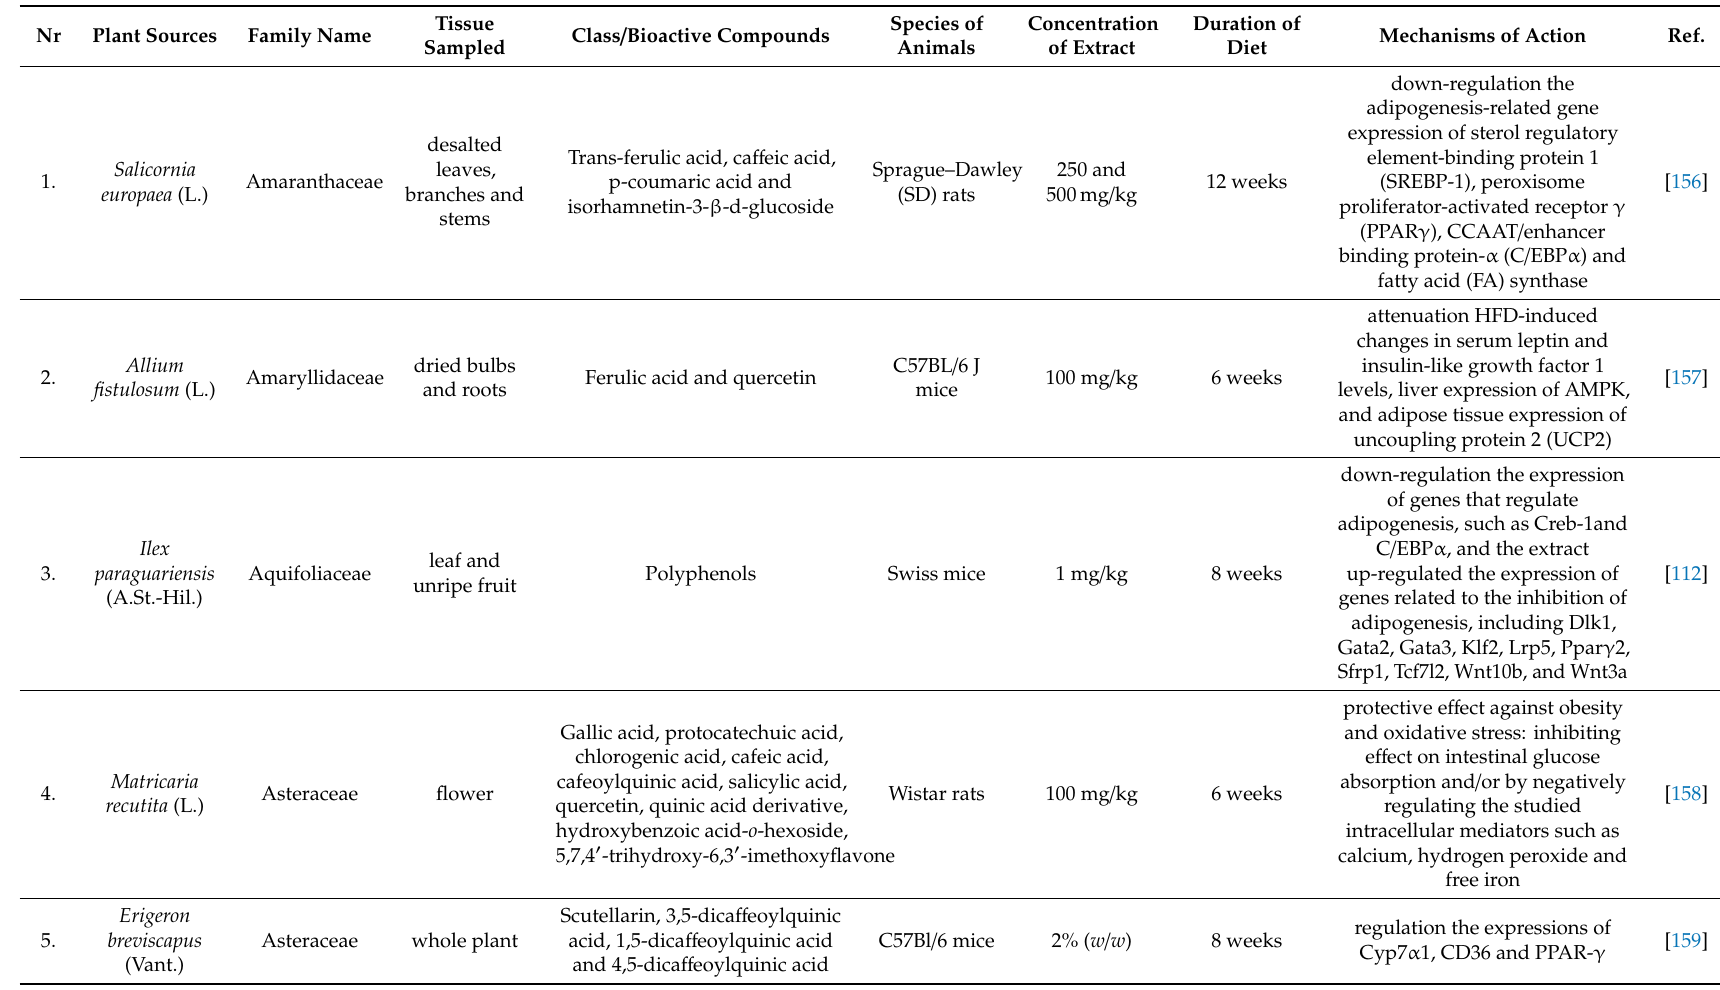
Table 3. Selected plant extracts with anti-obesity properties confirmed in in vivo mouse or rat